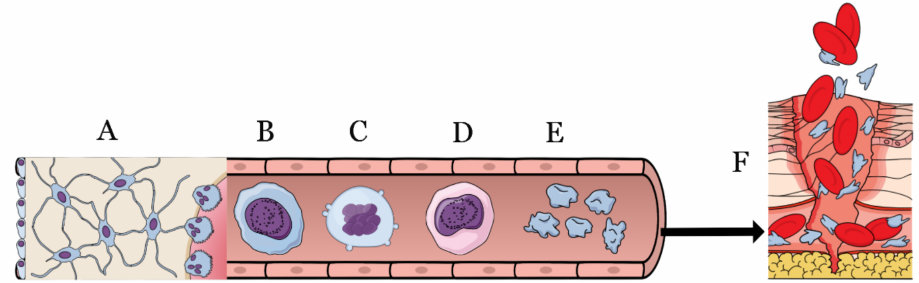
Figure 1. From the bone marrow ( A ) through the bloodstream, the megakaryoblast ( B ) evolves into megakaryocyte ( C , D ) to finally acquire the platelet form ( E ). Platelets are activated during the injures ( F ) by means of the coagulation cascade to block the blood loss and to start the very first steps of